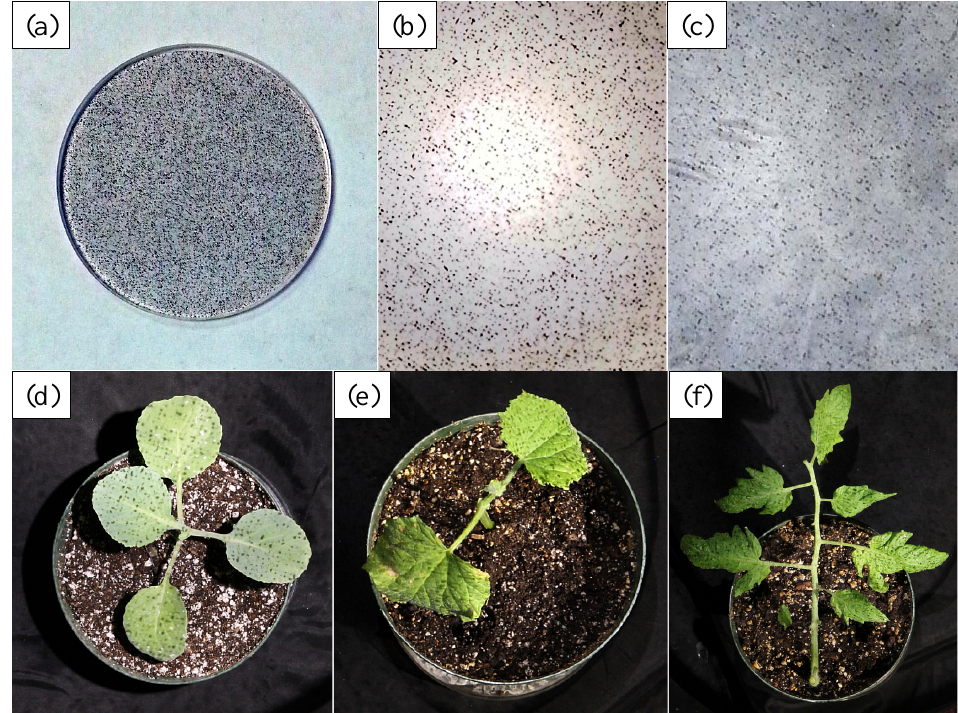
Figure 2. Random-dot pattern projected onto surfaces and plants: ( a ) the dot pattern printed on a transparency film (in this figure, it is under a transparent window); ( b ) an image of the pattern projected (with maximum brightness) on a piece of white paper; ( c ) an image of the pattern projected on a black curtain; ( d ) the pattern projected on a cabbage plant; ( e ) cucumber plant; and ( f ) a compound leaf from a big tomato